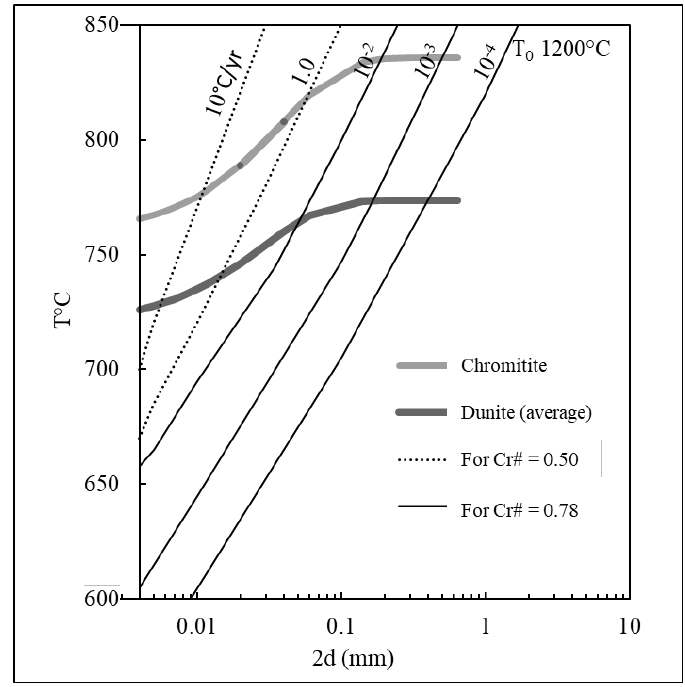
Figure 11. T (°C) vs. 2D plot of Iballe diffusion curves. Temperatures are calculated according to Fabriès [8]. Constant cooling rate curves for Cr# = 0.50 and Cr# = 0.78 are from Ozawa [35]. Results show that Iballe cooling rates are different for dunites and chromitites. The former show lower temperatures (Table 6) and a cooling rate variable but always higher than 10 − 2 ◦